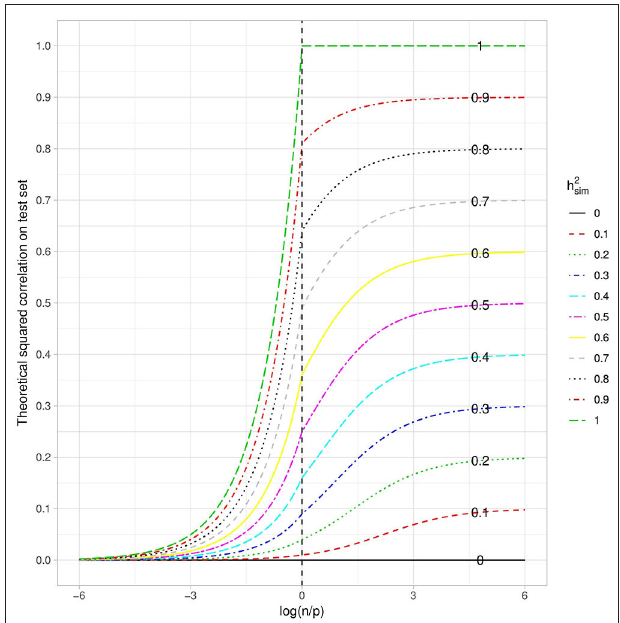
FIGURE 3 | Theoretical squared correlation between phenotype and its prediction with respect to the log ratio of the number of individuals over the number of variants in the training set. Each curve corresponds to a given heritability (in the narrow sense).